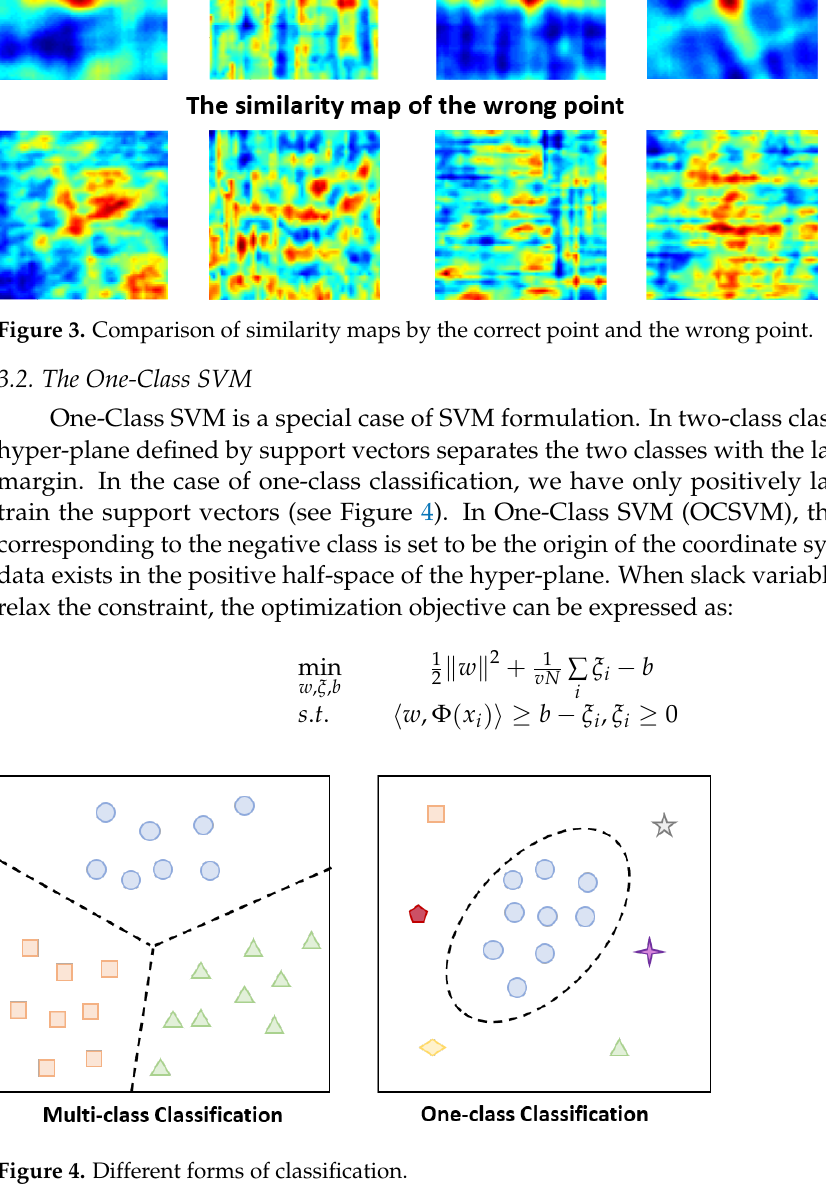
Figure 4. Different forms of